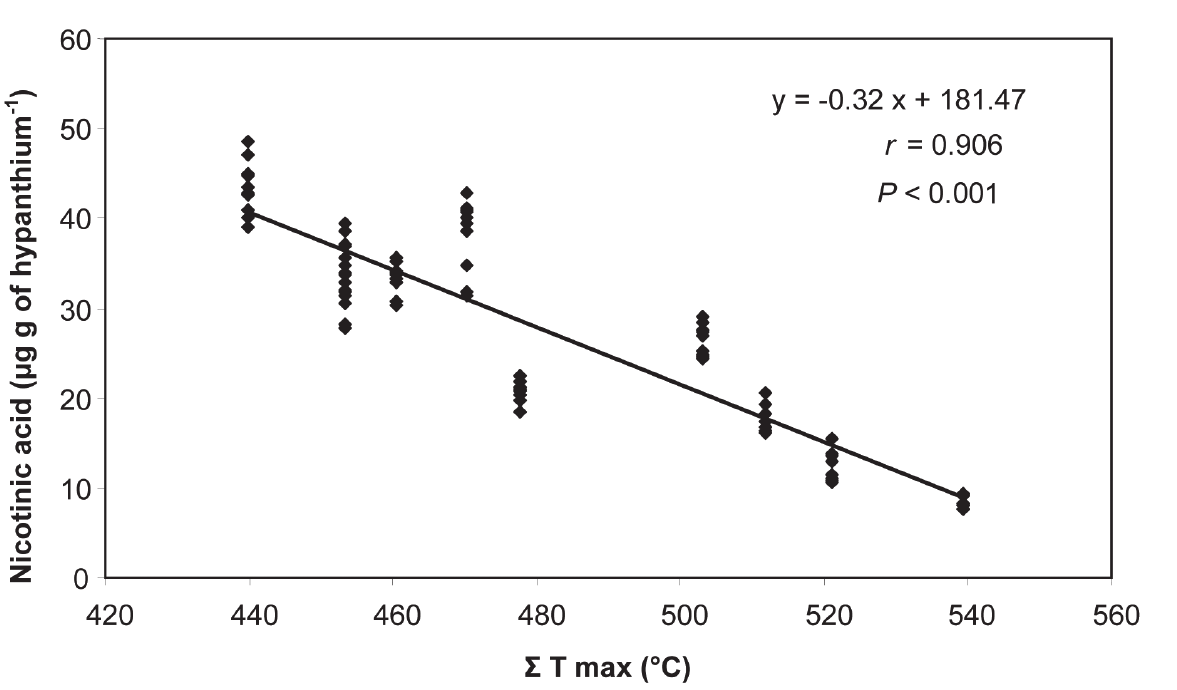
Figure 2. Relation between the amount of nicotinic acid (expressed as μ g g of hypanthium -1 ) on newly opened pear flowers and the sum of the maximum temperatures ( Σ T max) (°C) recorded during the 30 days before flowering. For additional information see the caption of Figure 1 and the table